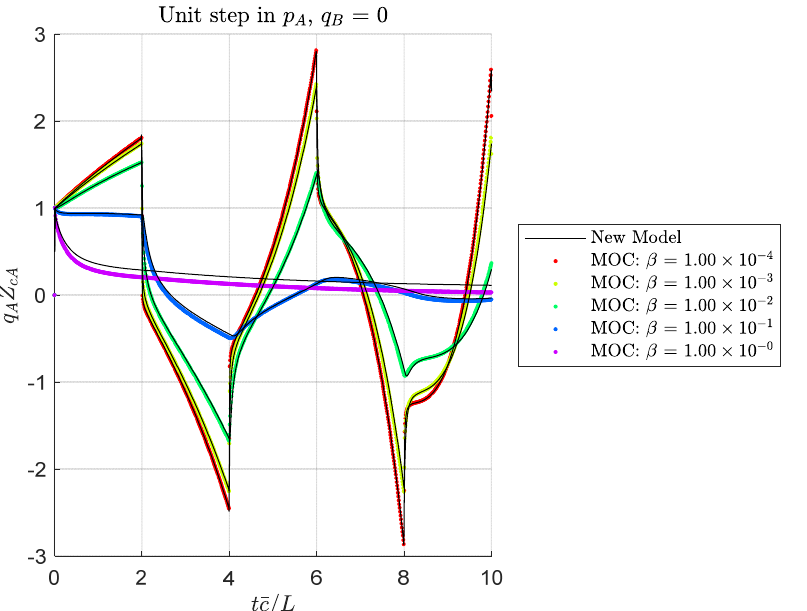
Figure 9. Inlet flow response to a unit step in inlet pressure for a closed exit, showing the effect of dissipation number (for (cid:3030) (cid:3251) (cid:3030) (cid:3250) = 0.5).